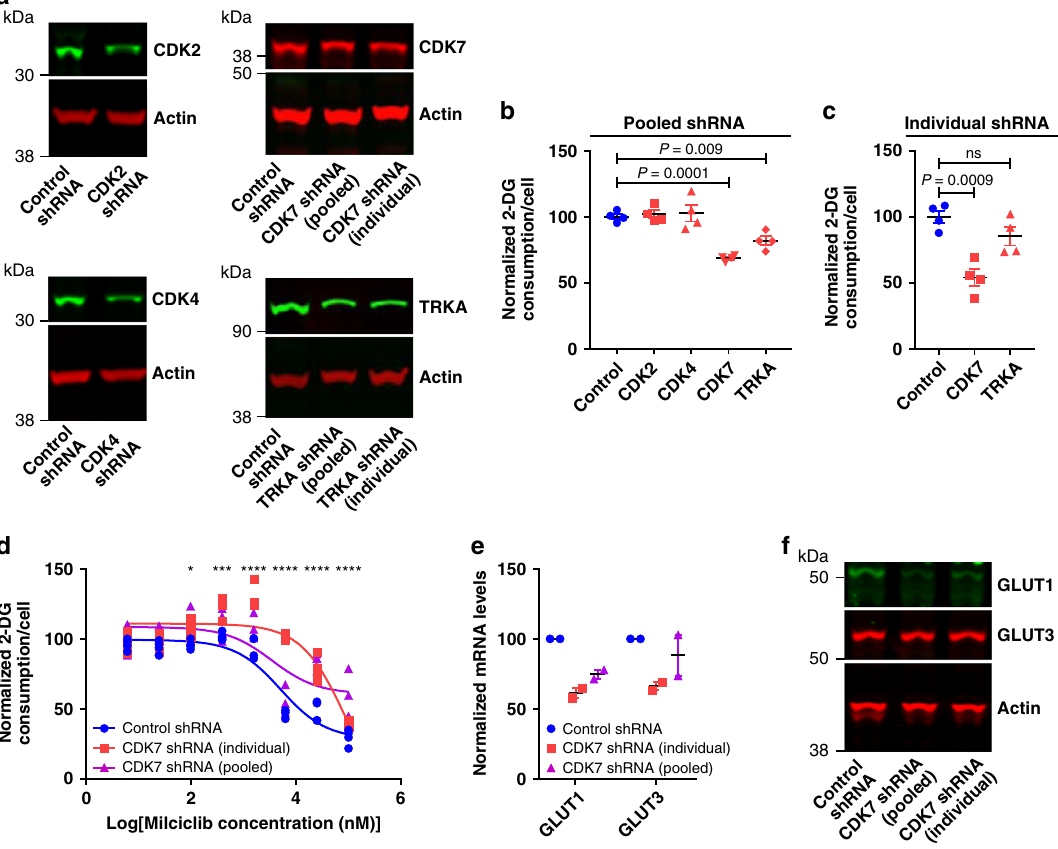
Fig. 5 CDK7 promotes glucose consumption in H460 cells. a Immunoblots of lysate from H460 cells transfected with control shRNA or shRNA targeted against CDK2, CDK4, CDK7, and TRKA. n = 2. Glucose consumption in H460 cells transfected with control shRNA or b pooled or c individual shRNA separately targeted against CDK2, CDK4, CDK7, and TRKA. n = 4. P values determined by one-way ANOVA tests. d Glucose consumption dose response curves in H460 cells transfected with control shRNA or shRNA targeted against CDK7 and treated with Milciclib. n = 4. P values determined by a two-way ANOVA test. e mRNA levels from H460 cells transfected with control shRNA or pooled or individual shRNA targeted against CDK7. n = 2. f Immunoblots of lysate from H460 cells transfected with control shRNA or pooled or individual shRNA targeted against CDK7. n = 2. ns: not signi fi cant. * P < 0.05; *** P < 0.001; **** P < 0.0001. Data are plotted as mean ± genetic alteration in the PI3K pathway 30 and the only cell line in which Milciclib, THZ1, and LDC4297 block glucose consumption (Fig. 3c, Supplementary Fig. 10a), suggesting a potential role for the PI3K-signaling pathway in regulating glucose consumption through CDK7. Neither Milciclib, THZ1, nor LDC4297 inhibit glucose consumption in HCC827 cells (Fig. 3c, Supplementary Fig. 10a). However overexpression of wild-type PIK3CA in HCC827 cells increased phospho-AKT levels by 244 ± 30%, increased phospho-CDK7 levels by 48.3 ± 3.7%, increased GLUT1 levels by 85.0 ± 0.1%, and sensitized HCC827 cells to the inhibitory effect of Milciclib, THZ1, and LDC4297 on glucose consumption without signi fi cantly affecting how much Milciclib inhibits cell growth (normalized cell numbers of control and PIK3CA overexpressing HCC827 cells treated with Milciclib: 66.1 ± 1.6% and 72.1 ± 2.4%, respectively; Fig. 6a, b, Supplemen- tary Fig. 14). The phosphatase and tensin homolog (PTEN) protein opposes the activity of PIK3CA 49 . Overexpression of PTEN in H460 cells decreased phospho-AKT levels by 55.5 ± 5.8%, decreased phospho-CDK7 levels by 38.7 ± 4.8%, decreased GLUT1 levels by 16.0 ± 1%, and blocked the inhibition of glucose consumption by Milciclib, THZ1, and LDC4297 without signi fi cantly affecting how much Milciclib inhibits cell growth (normalized cell numbers of control and PTEN-overexpressing